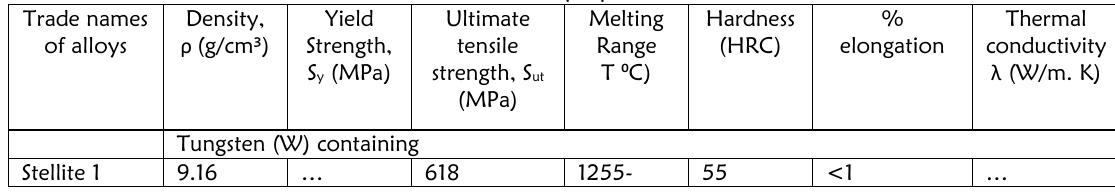
Table 2: Mechanical properties of